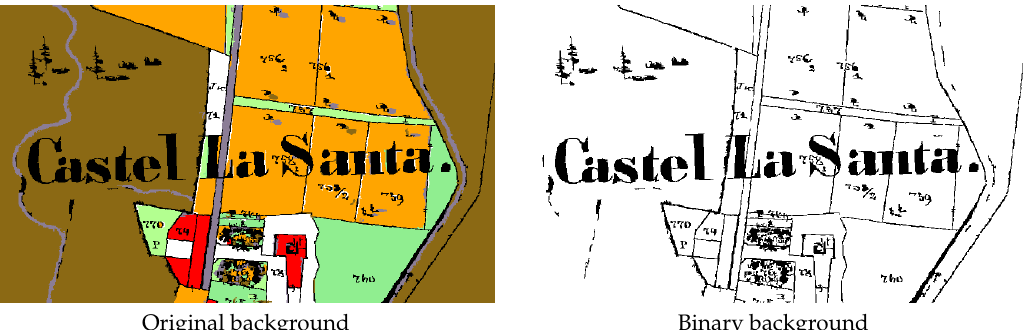
Figure 11. Test map containing text, symbols and lines from the classification of a real map. The left map has the original categories, the right one has been binarized with value 1 for text, symbols and lines and 0 for all other categories.